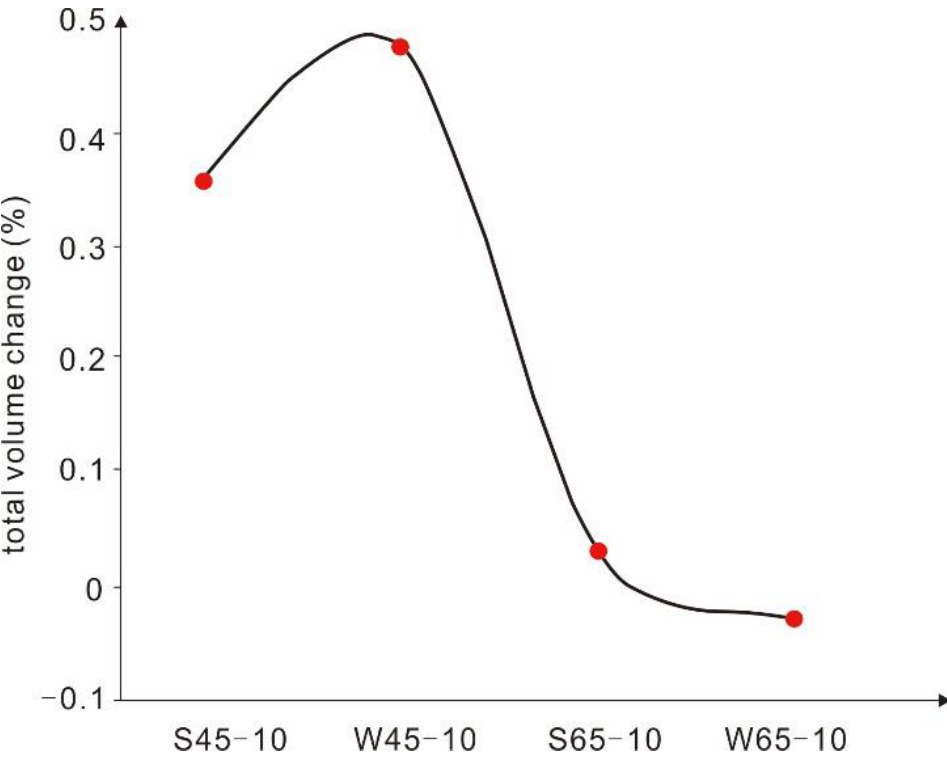
Figure 9. Characteristics of total mineral volume change under different temperature conditions.